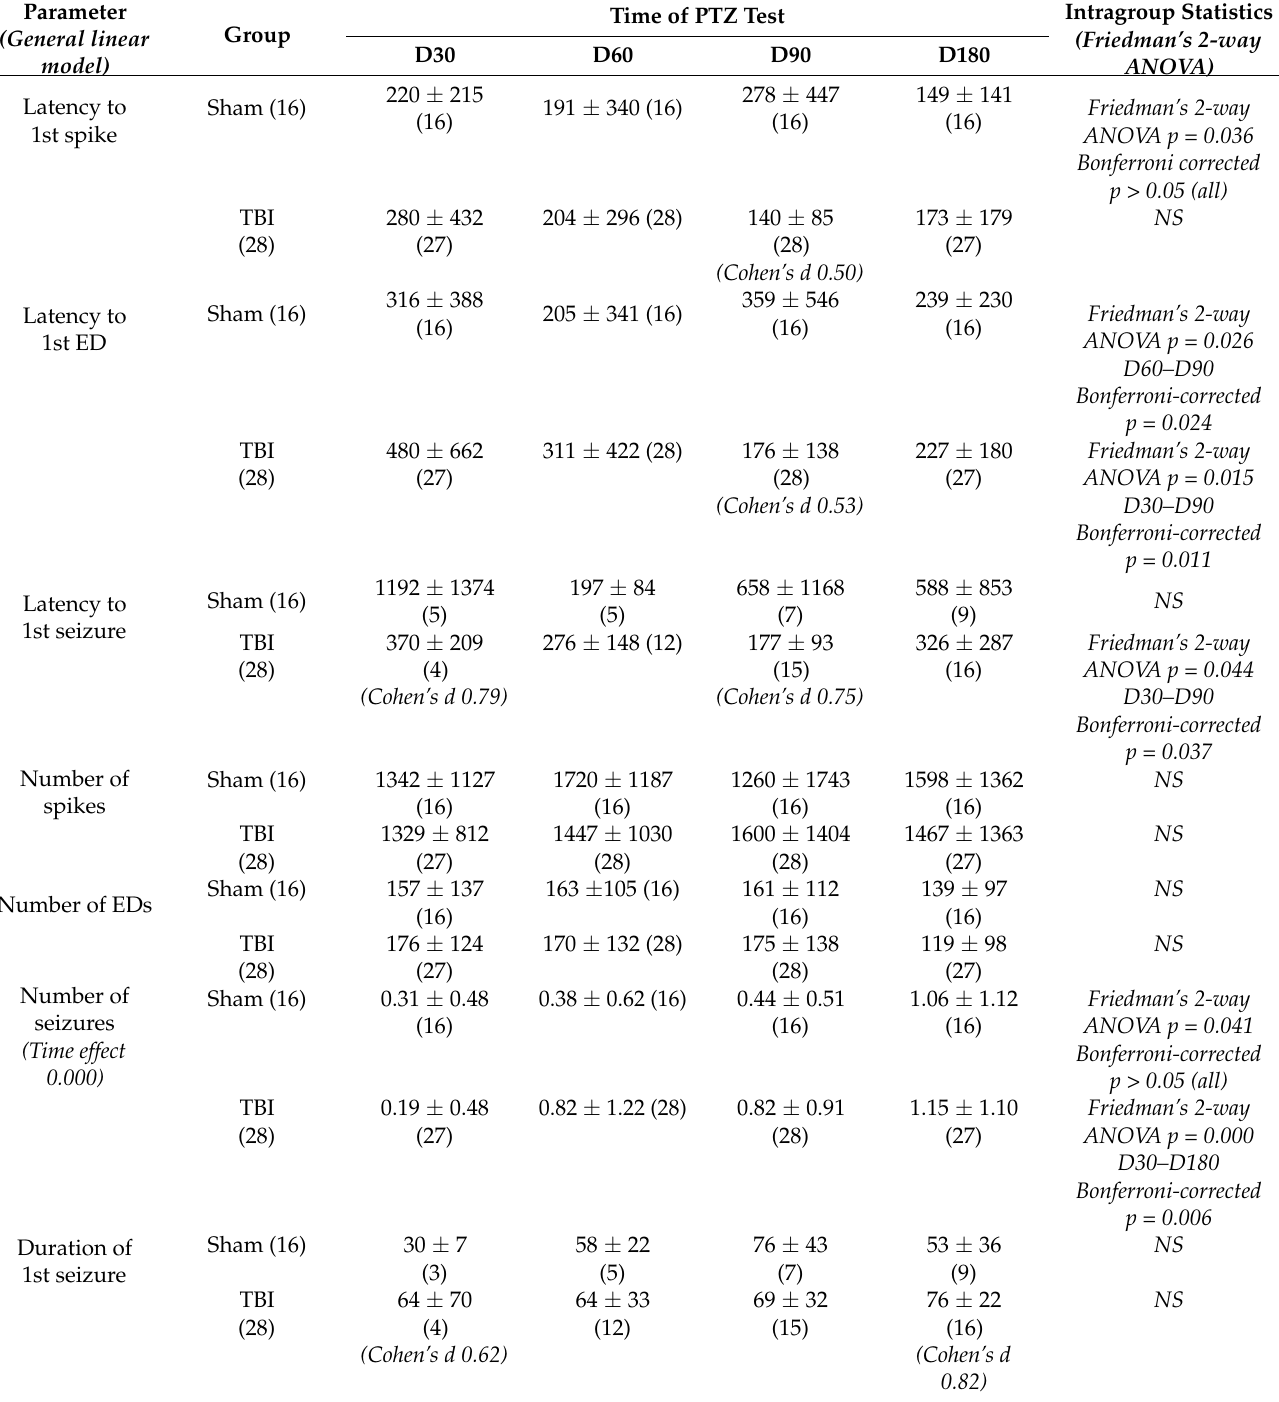
Table 1. Seizure susceptibility in the PTZ test on day (D) 30, D60, D90, and D180 after lateral-fluid- percussion-induced traumatic brain injury (TBI) or sham